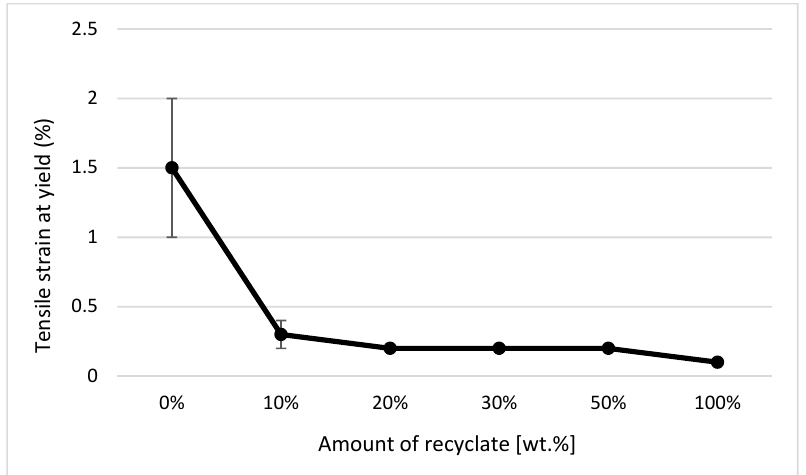
Figure 16. Dependence of stress at the break point on the proportion of weight of the recycled material after exposure of samples to elevated temperature.